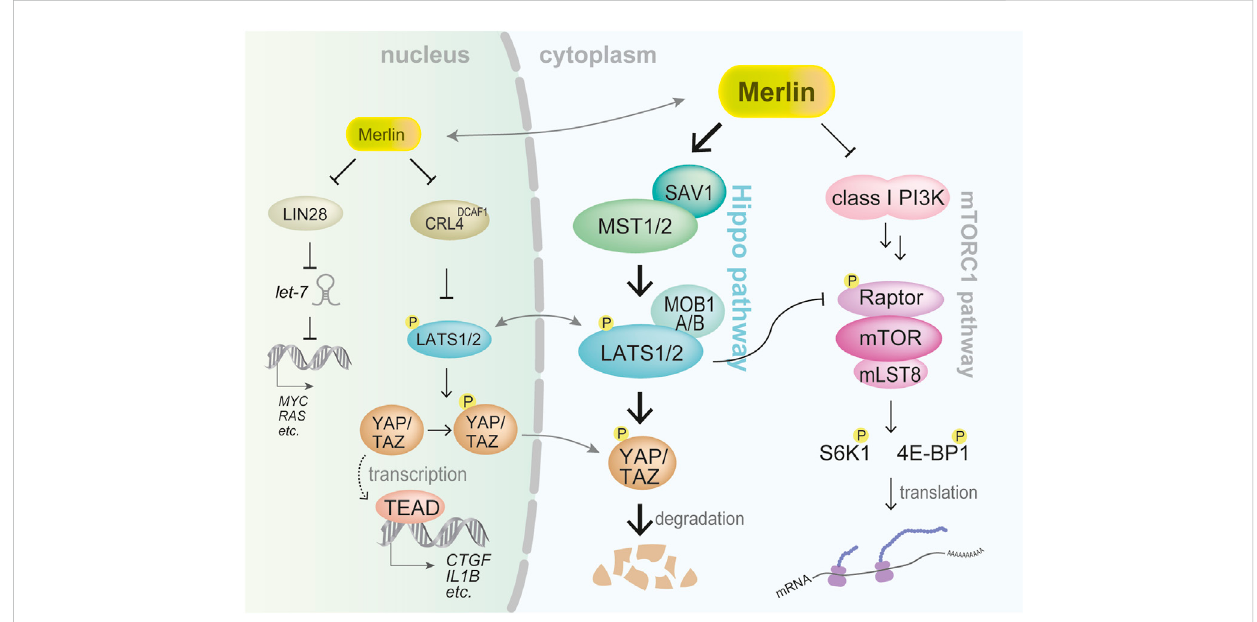
FIGURE 2 Representative signaling pathways regulated by merlin. Two signi fi cant downstream signaling pathways mediated through the cytoplasm are the Hippo and mTORC1 pathways. Under merlin inactivation, underphosphorylated (active) YAP/TAZ transcriptional coactivators bind to TEAD family transcription factor resulting in the expression of multiple prooncogenic genes such as CTGF and IL1B . Merlin also regulates mTORC1 activation that enhances translation of proteins. Merlin is also thought to translocate into the nucleus to exert its tumor-suppressive